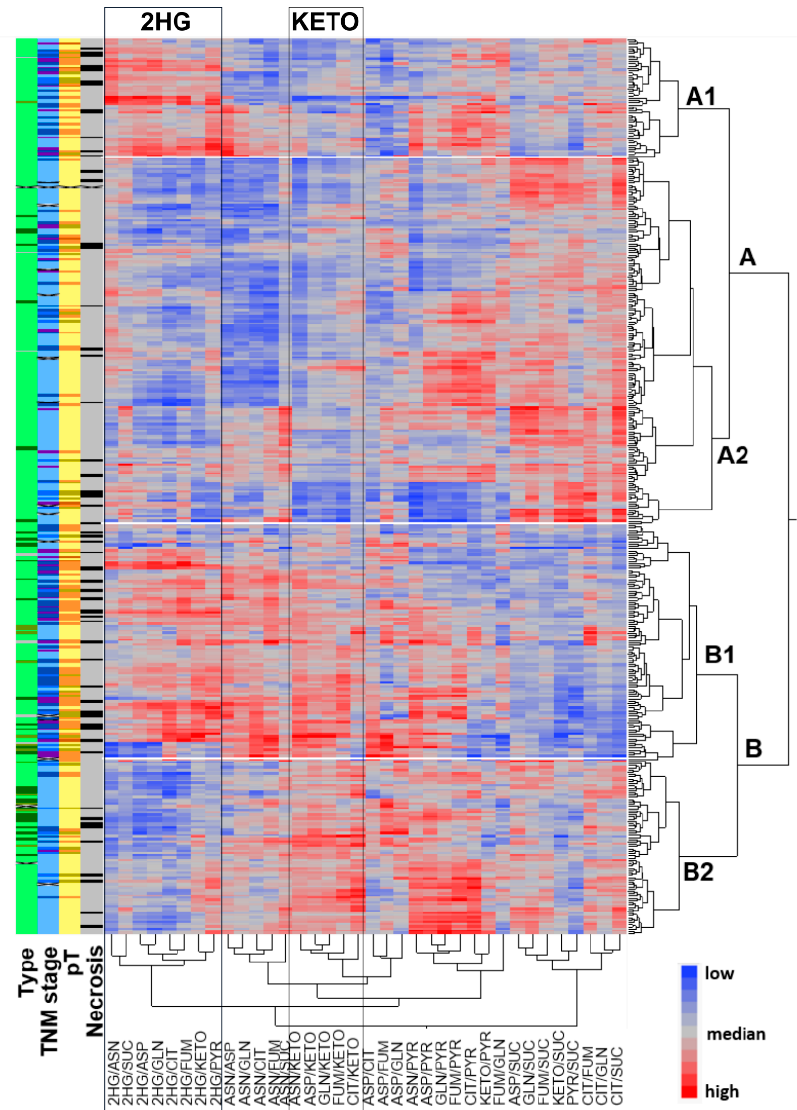
Figure 1. Unsupervised hierarchical clustering of metabolite ratios identified two main groups (A/B), predominantly based on differential α -ketoglutarate (KETO) levels. Each cluster contained two sub-clusters (1/2) characterised by differential 2HG levels. Colour coding: Necrosis—yes (black), no (grey); Primary tumour stage (pT) and TNM stage—darker is a higher stage; Type—CC (light green), P (dark green), CHR (olive), mixed type (grey).